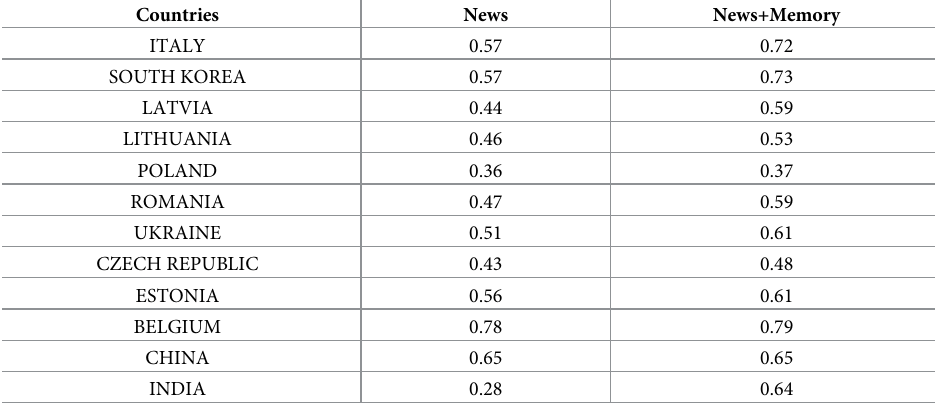
Table 2. Adjusted R 2 for the two linear regression models applied to predict Wikipedia